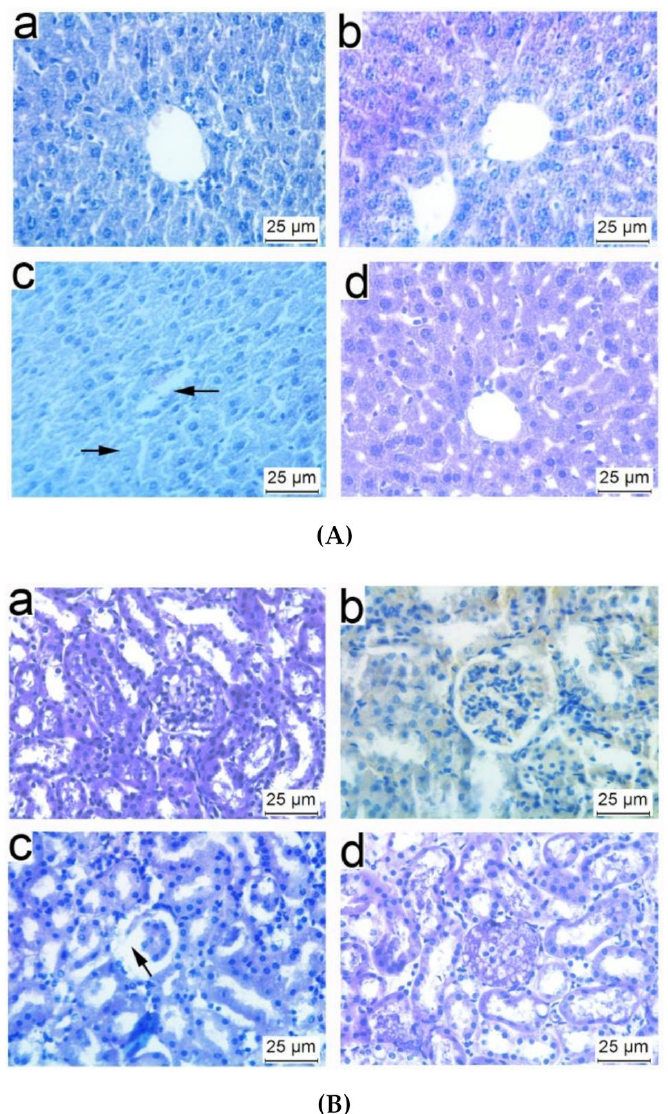
Figure 10. Histopathology of livers and kidneys of mice after immunization and E. coli challenge. Liver ( A ) and kidney ( B ) sections are shown with H&E staining at × 400 magnification. Mice were immunized with NP-OmpA (a), OmpA (b), or NC (c) and then challenged with E. coli , or immunized with NC and challenged with NC (d). After E. coli challenge, inflammatory cell infiltration in the central vein of liver tissue, nuclear apoptosis of liver cells, irregular cell morphology, uneven cytoplasm, and unclear hepatic sinuses were observed (Ac); the incomplete structure of kidney tissue, irregular glomerular and atrophy, and loose cells were observed (Bc). Thus, immunization with NP-OmpA can reduce the injury to the liver and kidney caused by E. coli